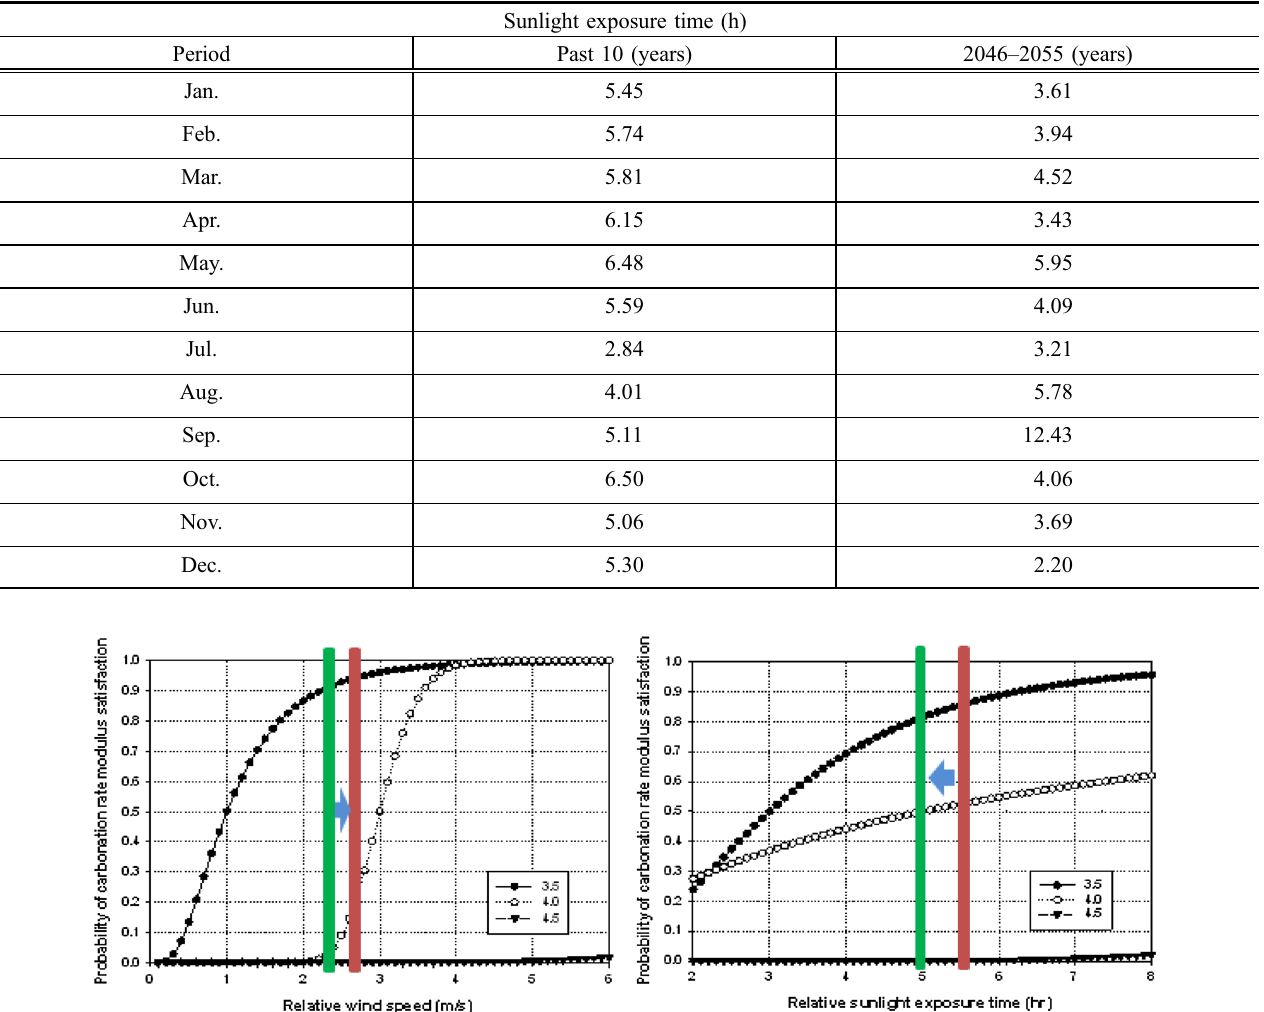
Table 9 Change in sunlight exposure time by RCP scenario.